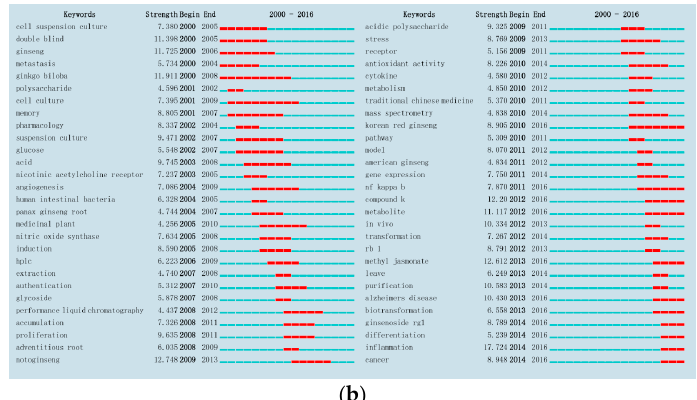
Figure 7. Major keywords of P. ginseng research and burst detection result. ( a ) Major keywords on P .